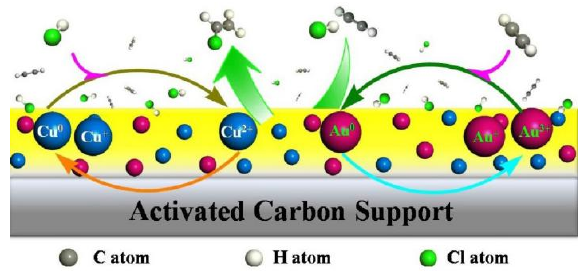
Figure 7. Au 3+ -Cu 2+ –IL/C catalyst for acetylene hydrochlorination [39]. IL: Ionic liquid.